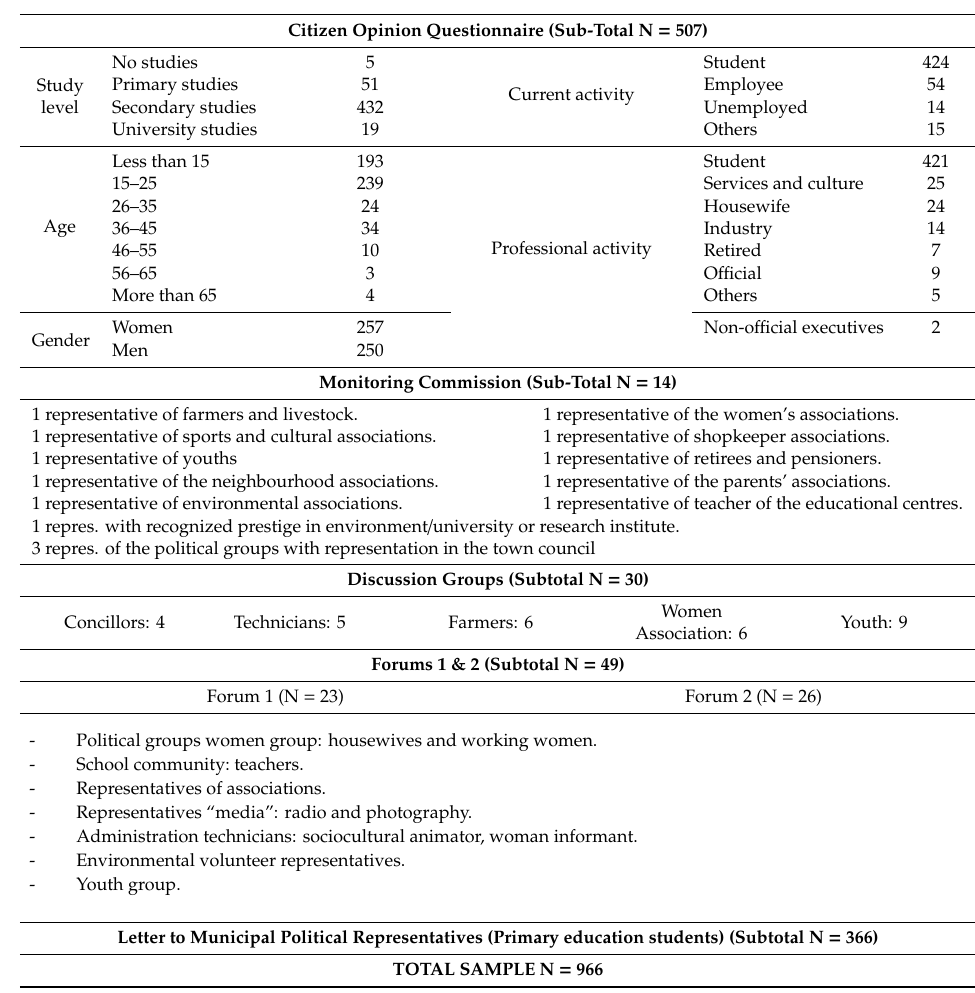
Table 3. Sample Total (N = 966).